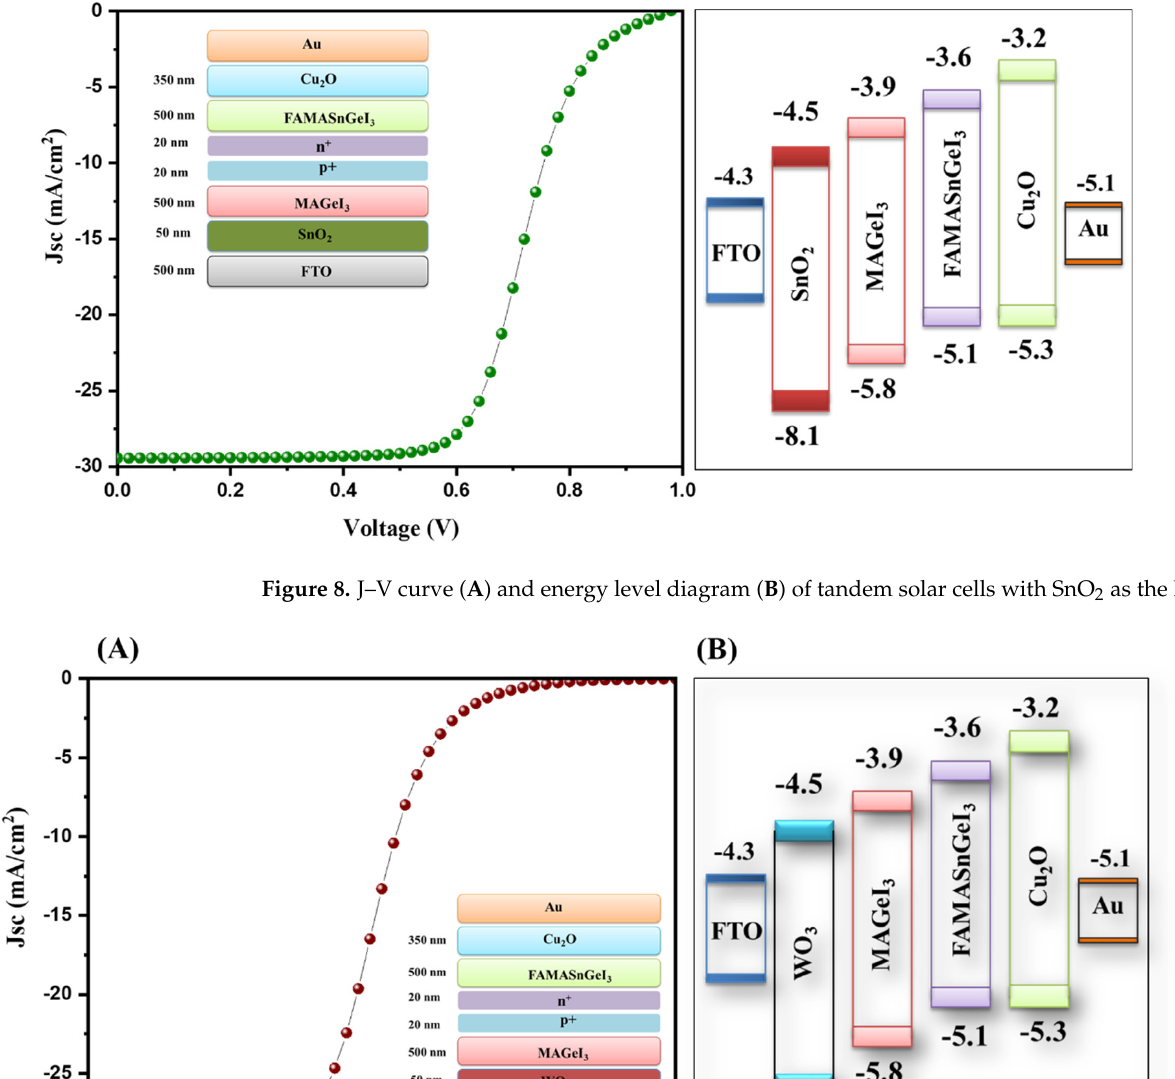
Figure 8. J–V curve ( A ) and energy level diagram ( B ) of tandem solar cells with SnO 2 as the ETL.